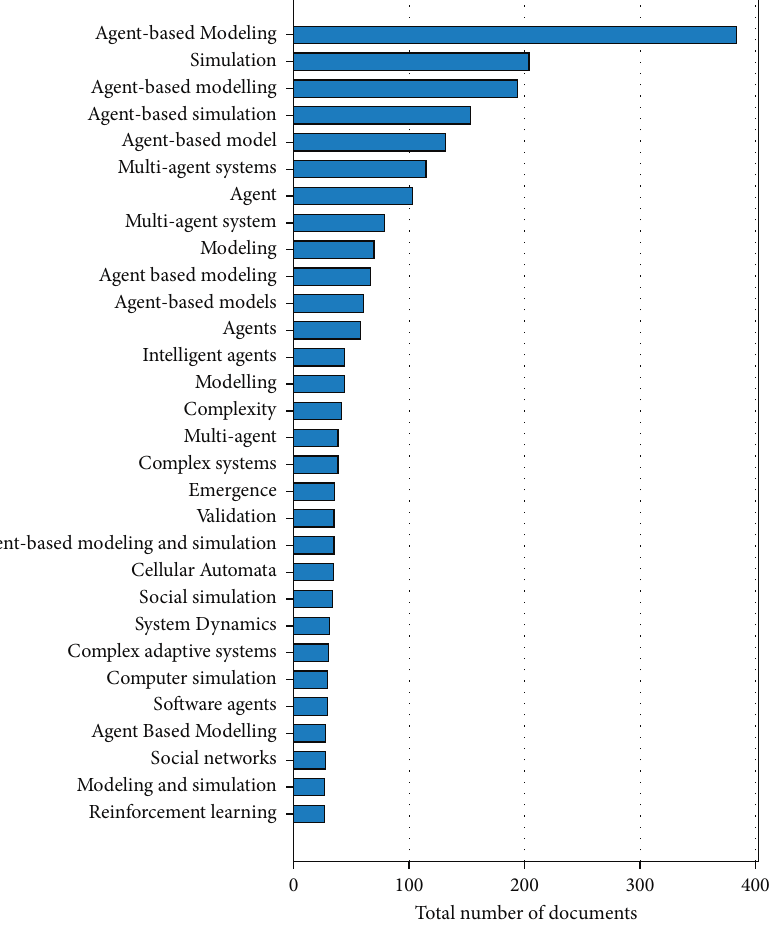
Figure 9: Bar chart of the top 30 authors’ keywords during 1991–2010.